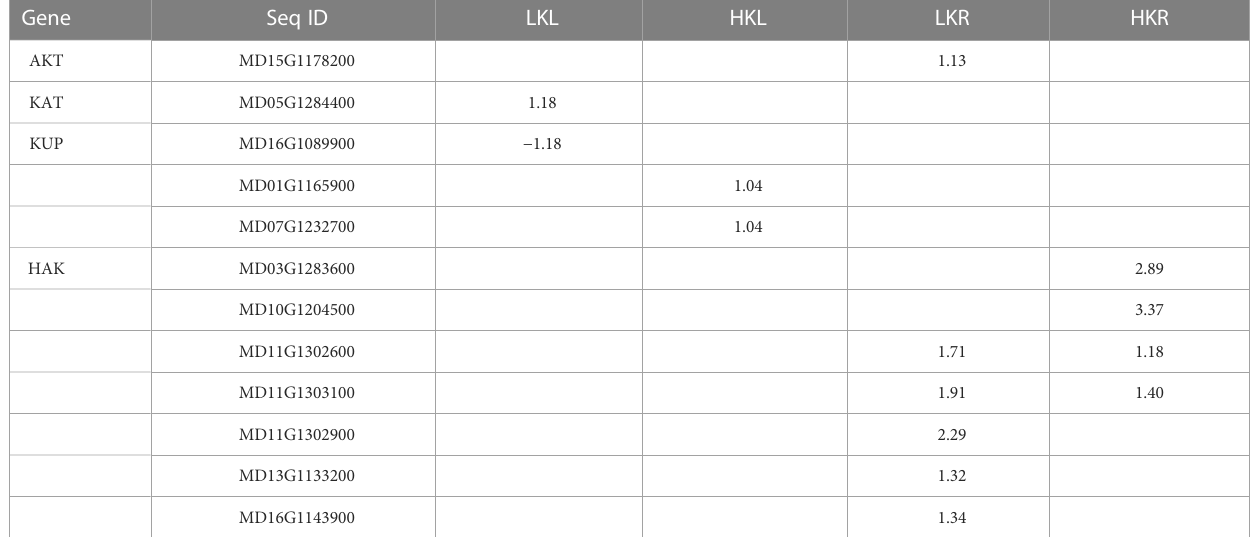
TABLE 3 Genes encoding transporters showed differential expression in response to different K